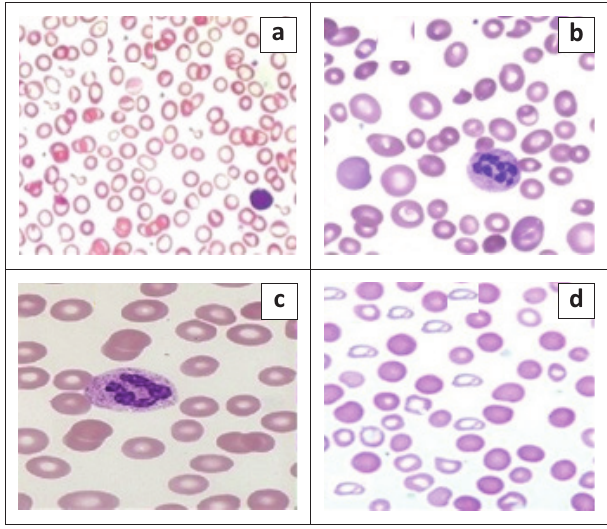
FIGURE 2: Photos of morphological patterns of anaemia, Sudan, September 2016 to February 2017. (a) Hypochromic microcytic, (b) macrocytic pattern, (c) normochromic normocytic and (d) dimorphic